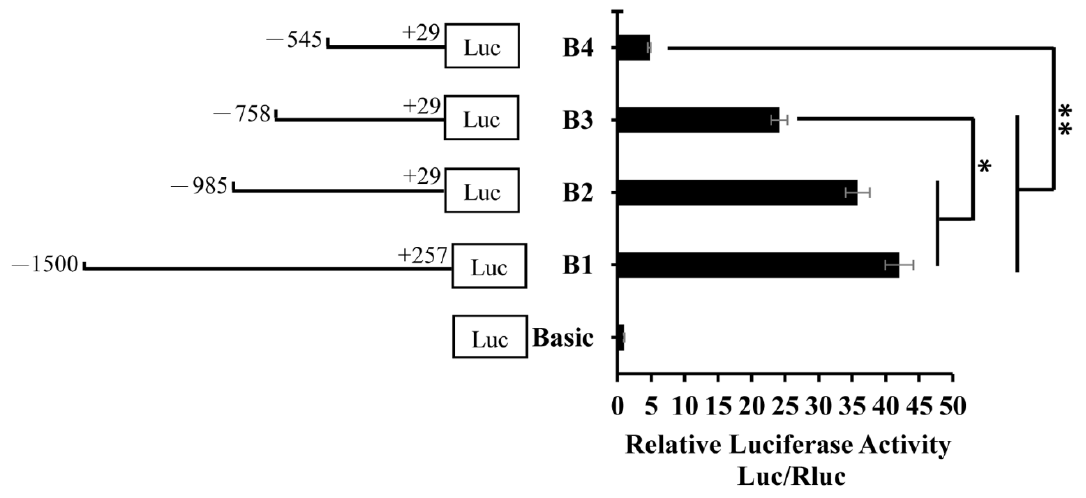
Figure 2. Relative luciferase activity of the Hu sheep BMP7 promoter with different lengths. Note that the basic was the pGL3-Base vector. For B1, the target fragment (−1500 bp to +257 bp) was ligated to the pGL3-Base vector; for B2, the target fragment (−985 bp to +29 bp) was ligated to the pGL3-Base vector; for B3, the target fragment ( − 758 bp to +29 bp) was ligated to the pGL3-Base vector; and for B4, the target fragment (−545 bp to +29 bp) was ligated to the pGL3-Base vector. The basic was the blank control group and B1 was the normal control group. The marker “*” represents a significant difference ( p < 0.05), while “**” represents a highly significant difference ( p < 0.01).